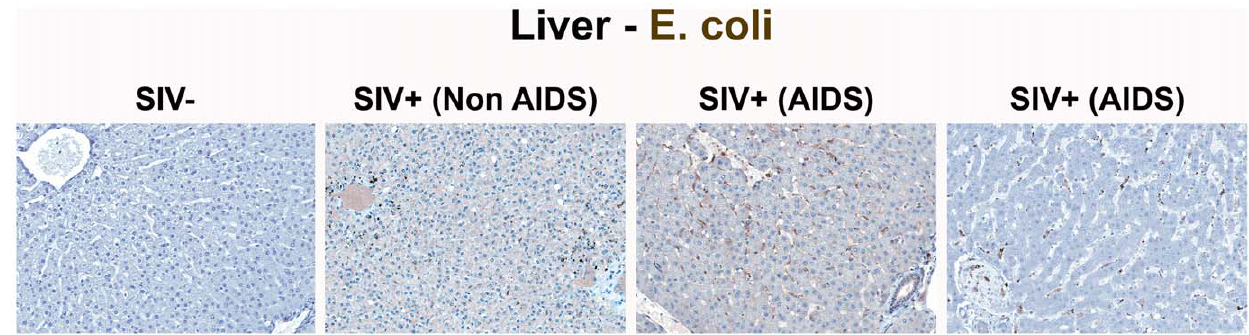
Figure 5. Identification of microbial translocation in the liver of chronically SIV + RMs. Representative images (200 6 ) of liver stained for E. coli constituents (brown). Note the increasing accumulation of microbial products near and surrounding the portal tract in chronically SIV + RMs with more severe disease but lack of microbial constituent staining seen in SIV-uninfected RMs.